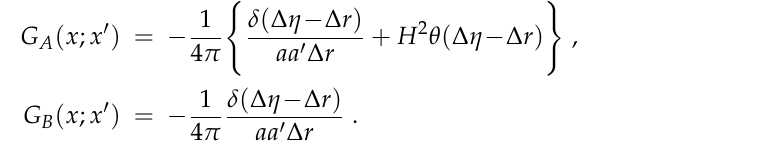
Table 14. Contributions for 6 iT 1 + 2 iT 2 + 2 iT 3 . Each tabulated term must be multiplied by κ 2